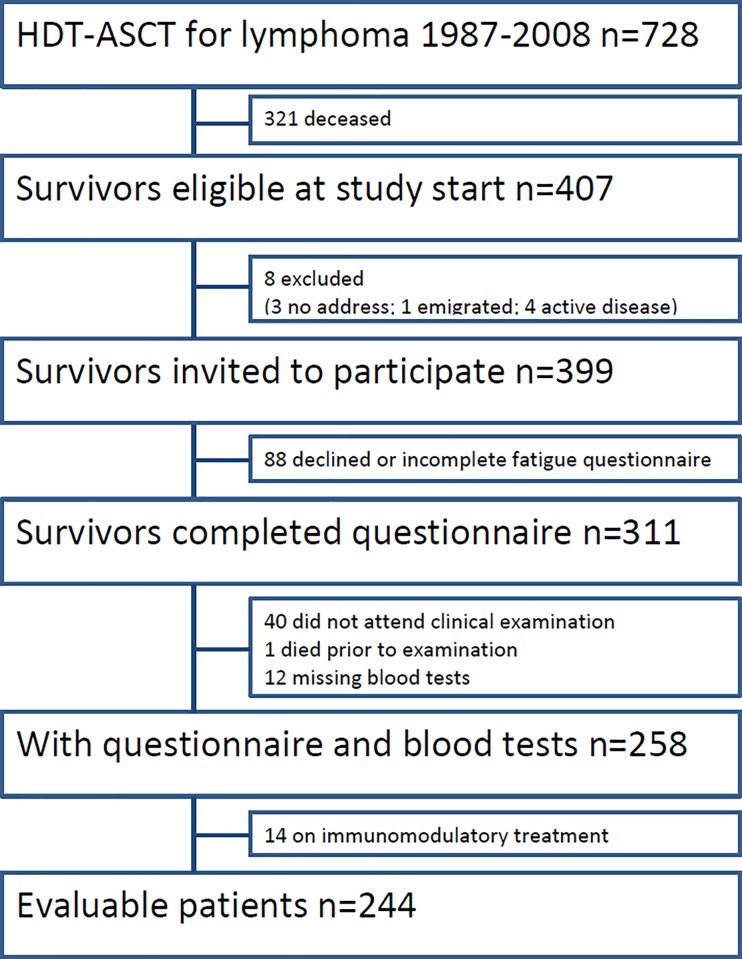
Patient flow chart.